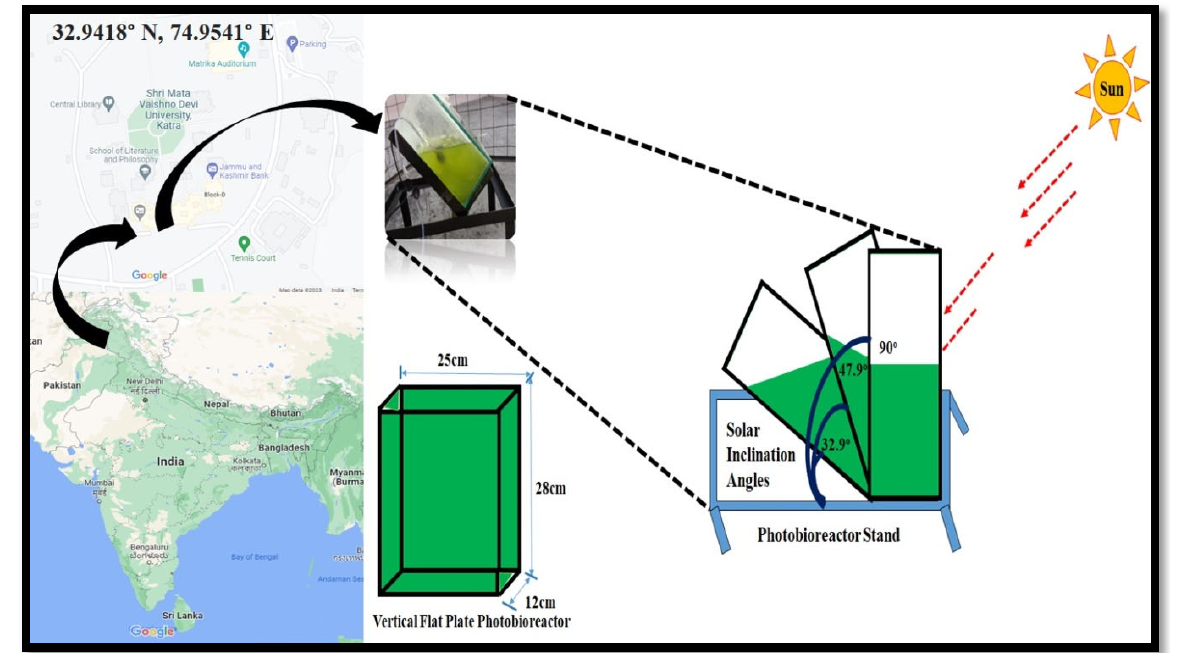
Figure 1. Schematic experimental set-up of FPPBR at different solar inclination angles (32.9 ◦ , 47.9 ◦ , and 90 ◦ ).